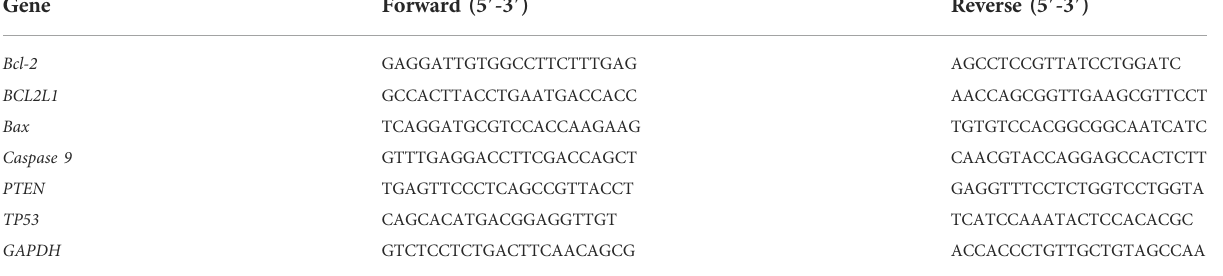
TABLE 1 Sequence of the primers used in quantitative real-time PCR